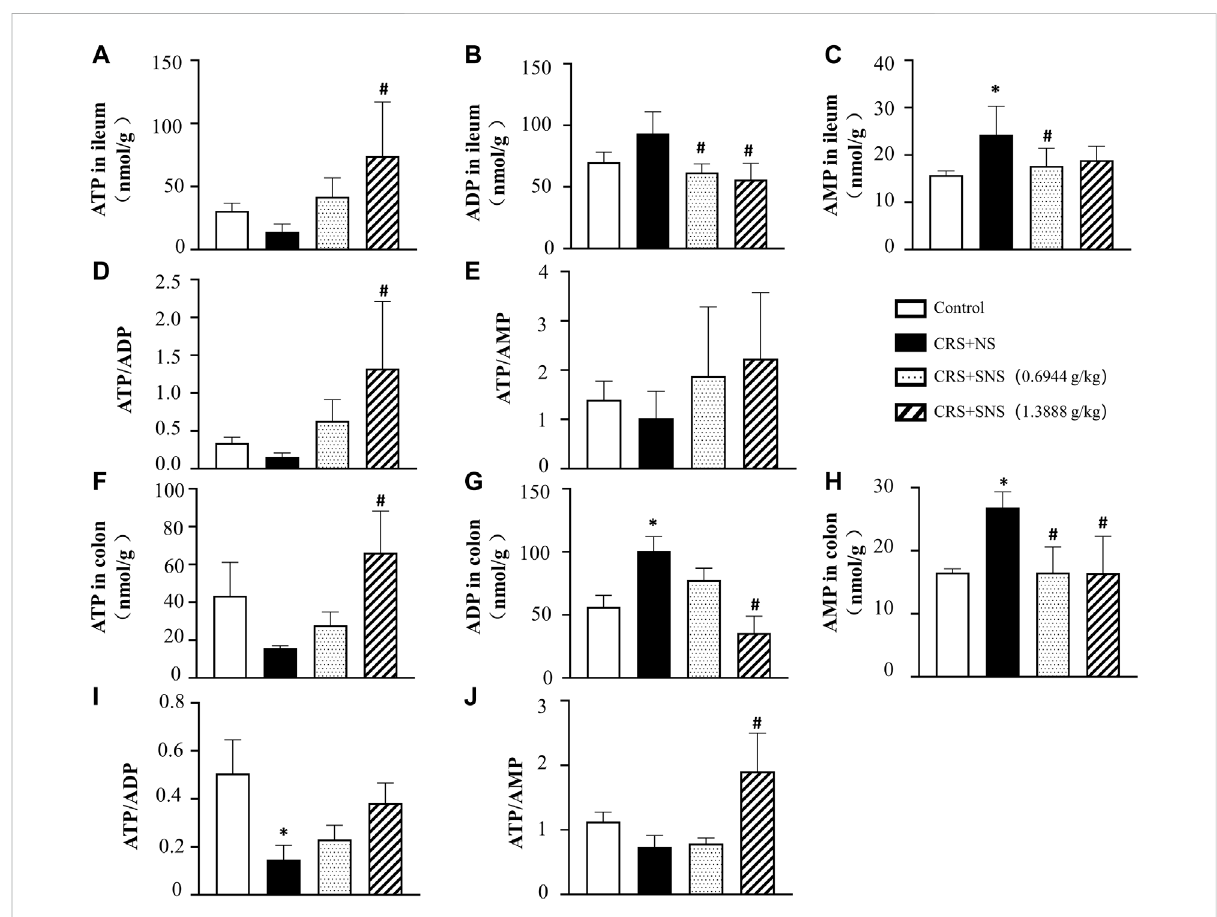
FIGURE 8 Effect of the SNS treatment on the levels of ATP, ADP, and AMP in the ileum and colon tissues. (A) ATP concentration in the ileum tissues from differentgroups.F=4.553. p =0.0237. (B) ADPconcentrationinileumtissues fromdifferentgroups.F=6.993. p =0.0021. (C) AMPconcentrationin ileum tissues from different groups. F = 4.918. p = 0.0102. (D) ATP/ADP in ileum tissues from different groups. F = 4.760. p = 0.0207. (E) ATP/AMP in ileumtissuesfromdifferentgroups.F=1.394. p =0.2738. (F) ATPconcentrationincolontissuesfromdifferentgroups.F=4.228. p =0.0295. (G) ADP concentration in colon tissues from different groups. F = 17.38. p = 0.0001. (H) AMP concentration in colon tissues from different groups. F = 7.342. p = 0.0047. (I) ATP/ADP in colon tissues from different groups. F = 4.419. p = 0.0259. (J) ATP/AMP in colon tissues from different groups. F = 9.628. p = 0.0016. Results are presented as mean ± SEM. * p < 0.05 vs. Control group; # p < 0.05 vs. CRS + NS group, (B,C,E) n = 6. ((A,D,F – J) n =